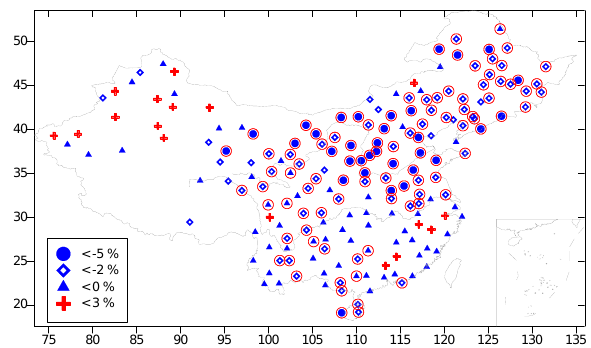
Fig. 4. The same as Fig. 1, but for annual rainy days at 192 mete- Figure 4. The same as Figure 1, but for annual rain day at 192 meteorological stations. orological stations. The decline in rainy days over much of China The decline in rain day over much of China is in agreement with the analysis of cloud is in agreement with the analysis of the cloud amount data (Kaiser, amount data (Kaiser, 1998). 1998). Figure 5.